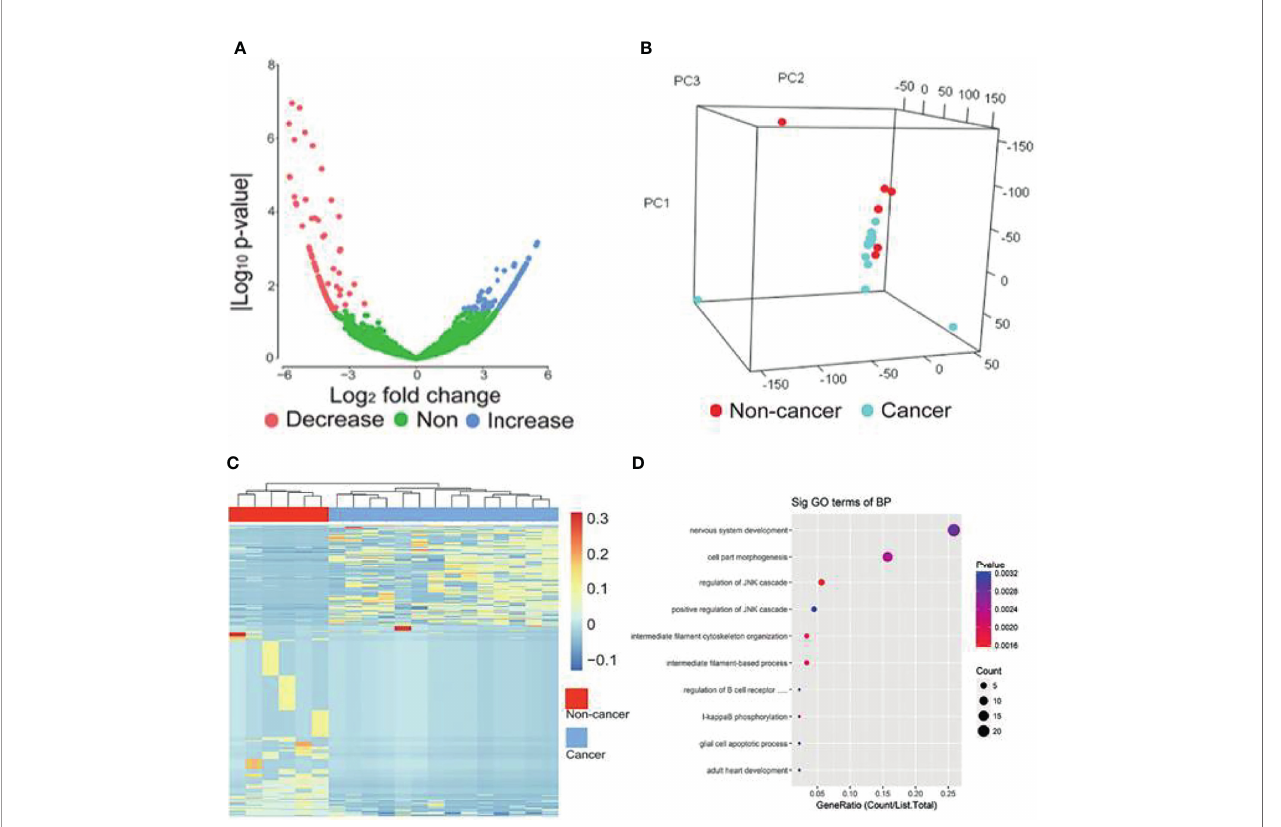
FIGURE 3 | circRNAs with signi fi cantly different levels. (A) Volcano plots of circRNAs with signi fi cant different levels (|log2 fold change| ≥ 2 and P -value < 0.05 produced by edgR package of R software) between cancer and control groups. (B) PCA analysis of genome-wide RNA sequencing data derived from 14 breast cancer patients and 6 benign patients. (C) Heat map of the z-scores of circRNAs with signi fi cantly different levels. (D) Gene function enrichment analysis of the host genes of the circRNAs with signi fi cantly different levels. Decrease, circRNAs with decreased levels. Non, circRNAs with non-signi fi cant changes. Increase, circRNAs increased